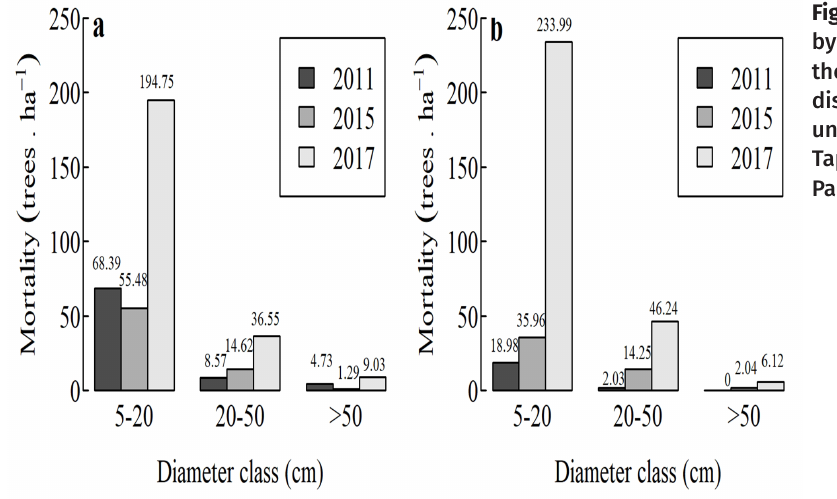
Figure 5. Tree mortality by diameter classes over the monitoring period in disturbed forest (a) and undisturbed forest (b), Tapajós National Forest, Pará,